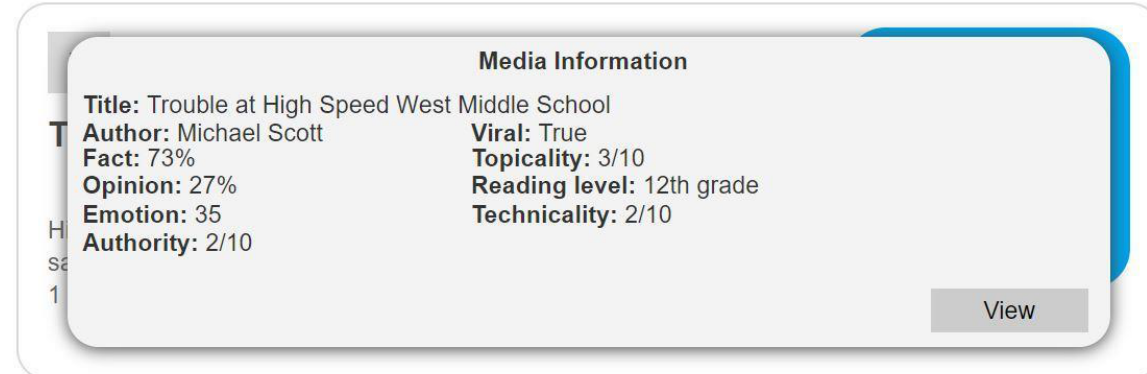
Figure 20. Informational label 2 [16].